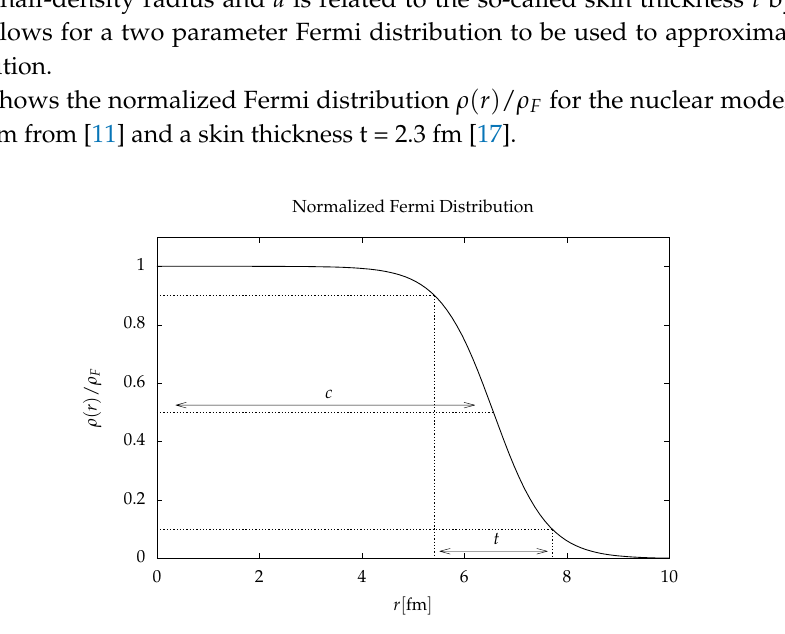
Figure 1. Fermi distribution with half-density radius c and skin thickness t for the nuclear model of 199